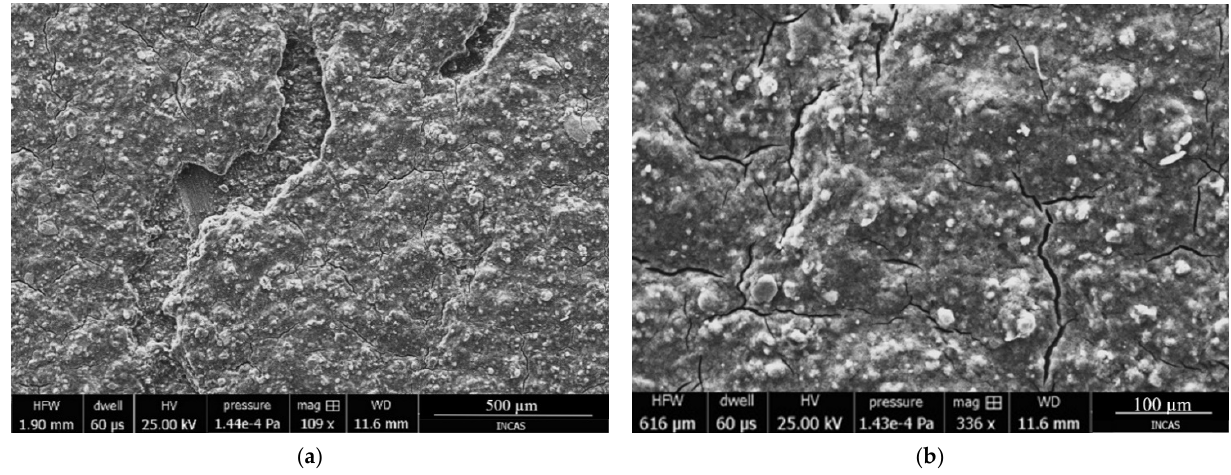
8 of 11 Figure 7. Microscopic image of the test specimen cross section after testing, showing the changes in thickness at different magnifications: ( a ) layer view with a magnification of 20×; ( b ) layer view with a magnification of 40×. The SEM analysis was performed on the specimens obtained before (Figures 8 and 9) and after (Figure 10) being tested in UV light. The images shown are for corundum blasted models. Although it is not highlighted very well in the images showing the sample cross section (Figure 9), the specimens presented are with two layers of paint, the screen layer